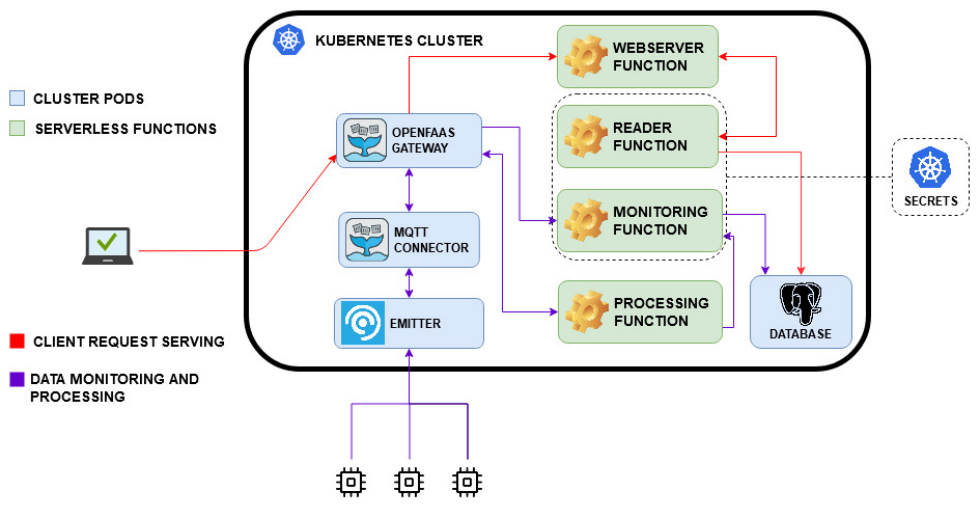
Figure 1. In the test platform, serverless functions are deployed in a Kubernetes cluster using the OpenFaas framework [10] to monitor, process and expose via webserver external event messages, published on an Message Queuing Telemetry Transport (MQTT) Emitter broker (FaaS stands for Function-as-a-Service)